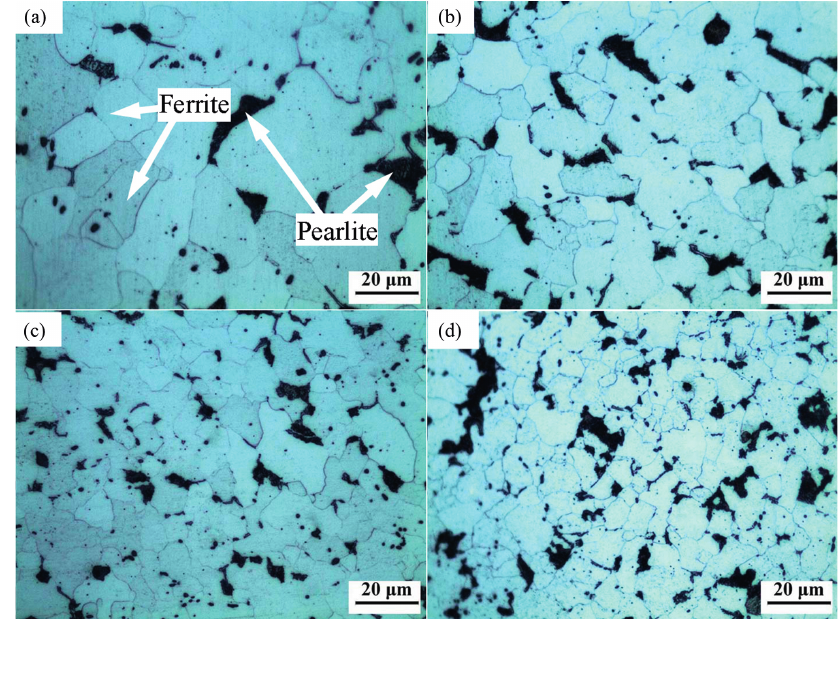
Figure 1: Optical microstructures of different samples: (a) sample 1 without Ce, (b) sample 2 with 0.0014% Ce, (c) sample 3 with 0.0020% Ce, (d) sample 4 with 0.0025% Ce.